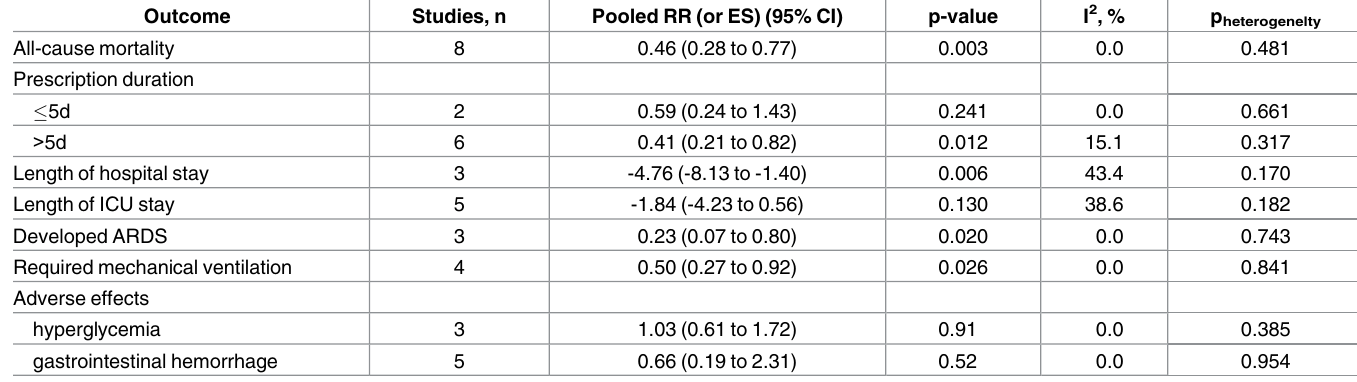
Table 4. Main results for binary outcomes (Mantel-Haenszel method, random effect model).